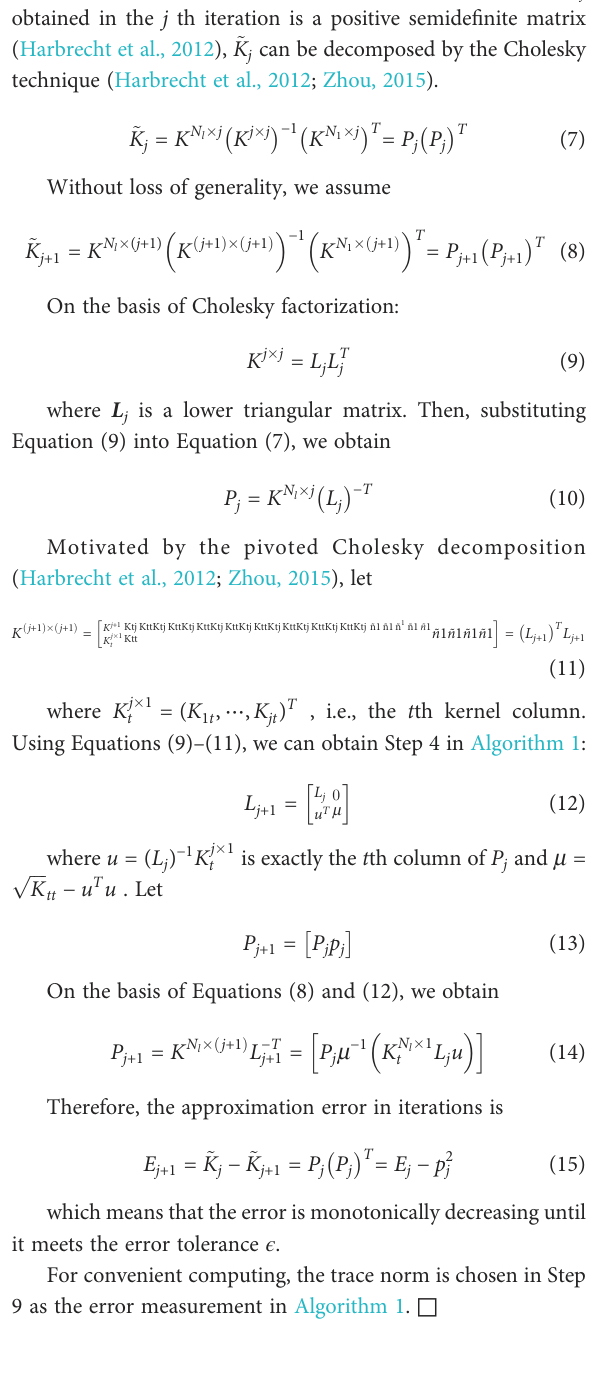
‖ = ‖ K ( ‘ ) − K ( ‘ ) ‖ ≤ e , where ϵ i i i